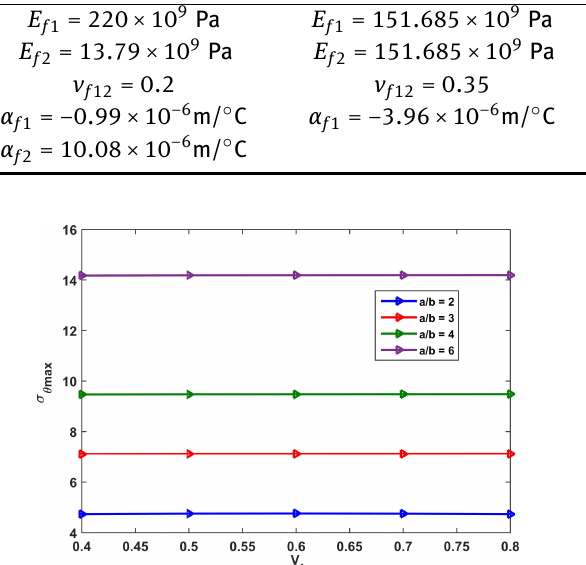
Figure 11: Effect of fibre volume fraction on σ θ max for ( σ ∞ x = 1 , [0